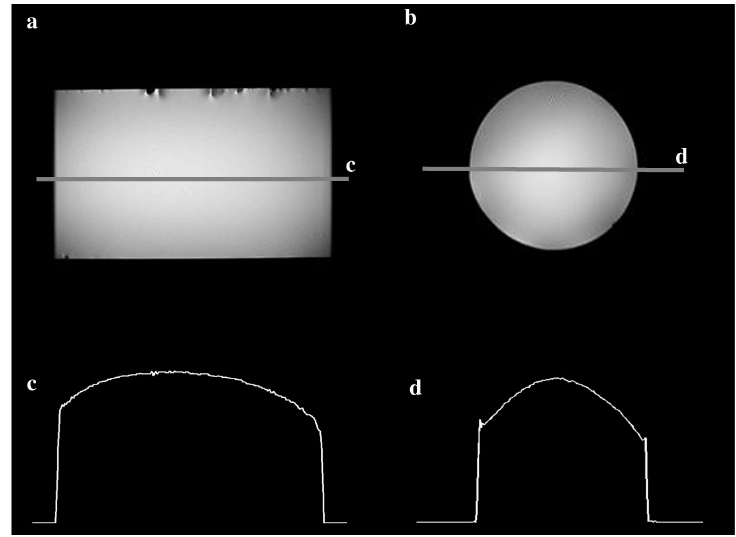
Figure 4. Fast spin echo proton images of a cylindrical water phantom in ( a ) sagittal plane and ( b ) axial plane using the 16-strut common-mode volume coil at 7T; ( c ) and ( d ) are 1D profiles on the central lines of the sagittal image and axial image, respectively. Despite the dielectric resonance effect at the ultrahigh field of 7T, comparatively homogeneous images were obtained using the common-mode volume coil with only 8